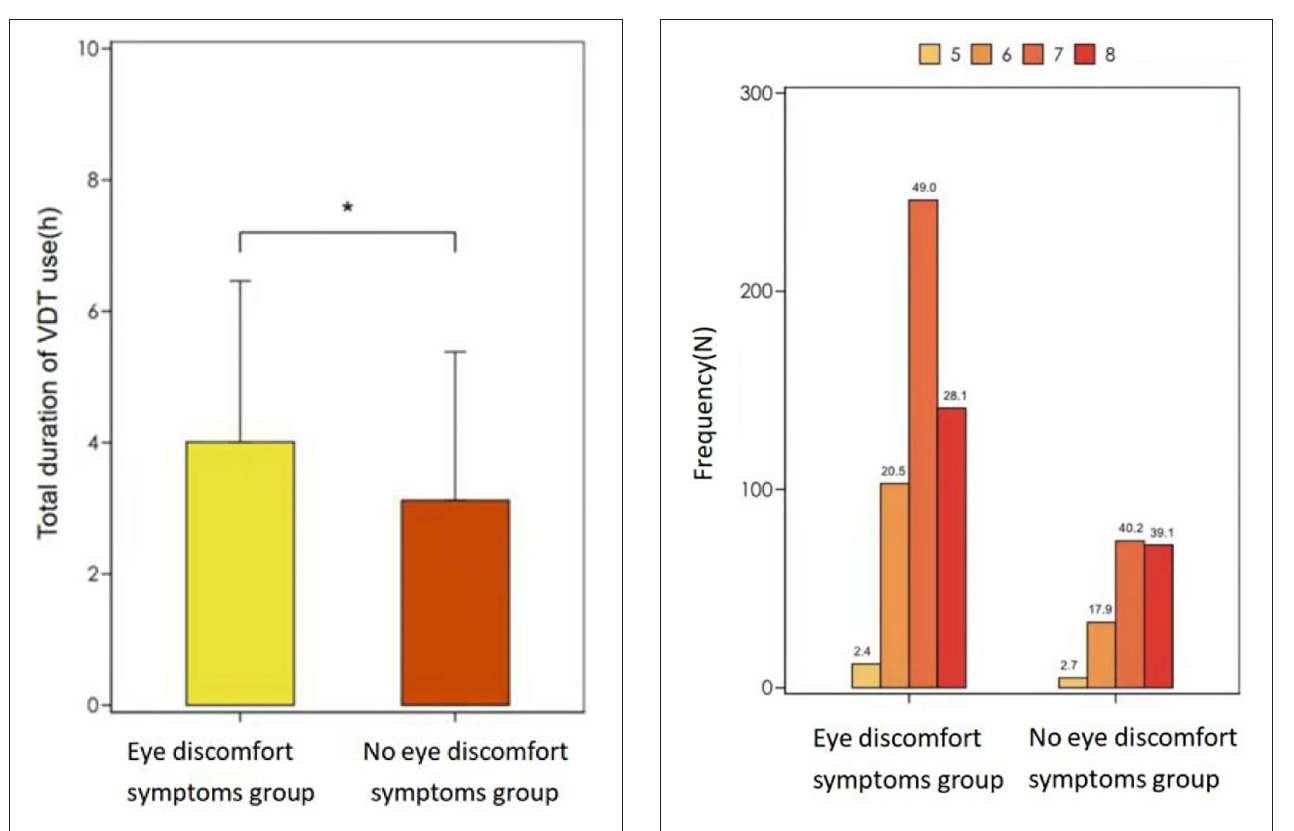
FIGURE 1 | Total duration of VDT use, eye discomfort symptoms group vs. no eye discomfort symptoms group. *means the difference between the two groups has statistically significant.